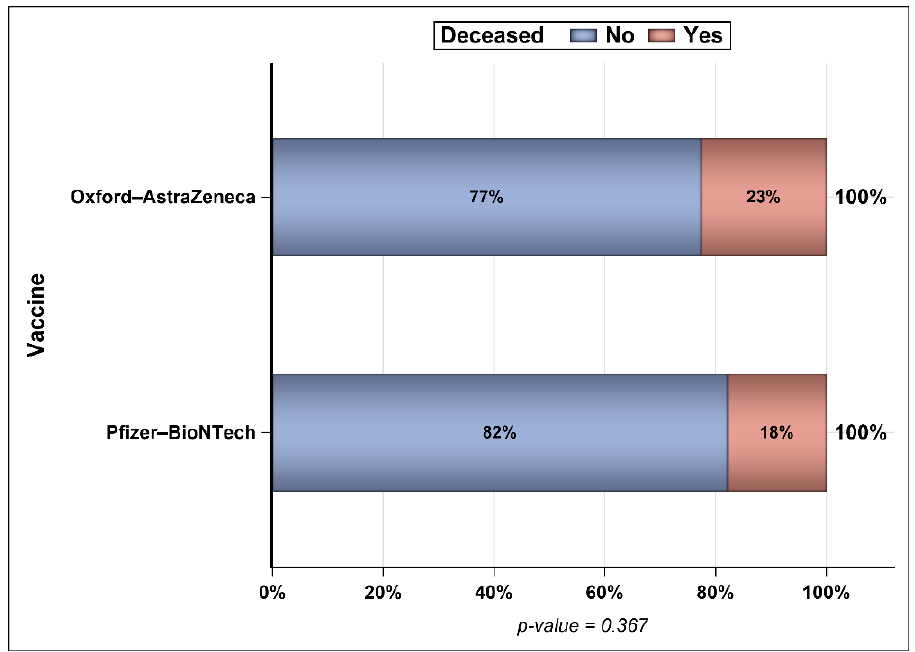
Figure 8. Percentage of deceased patients among those infected after vaccination and admitted to ICUs (n = 252).